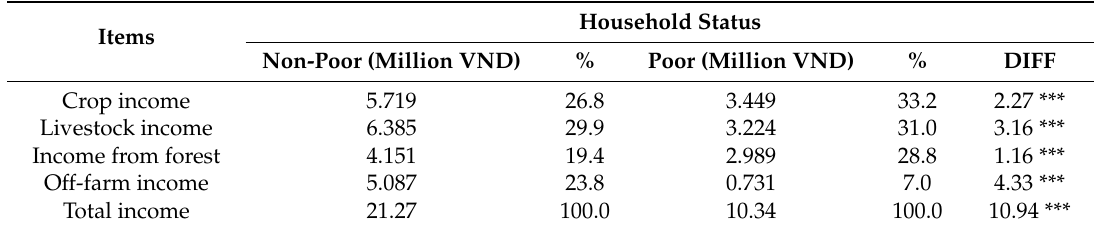
Table 7. Source of income by household type, Con Cuong District, Nghe An Province, 2016. Items